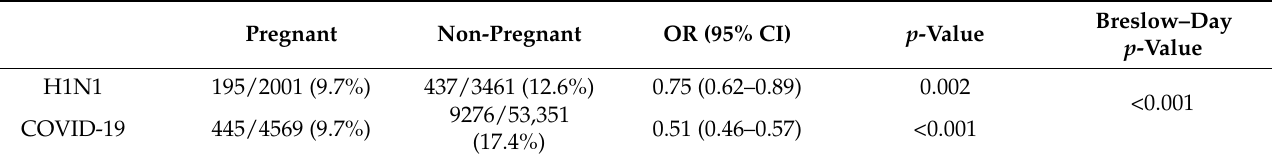
Table 3. Mortality rate of hospitalized childbearing-aged women with SARS during H1N1 (2009/2010) and COVID-19 (2020/2021) pandemics in